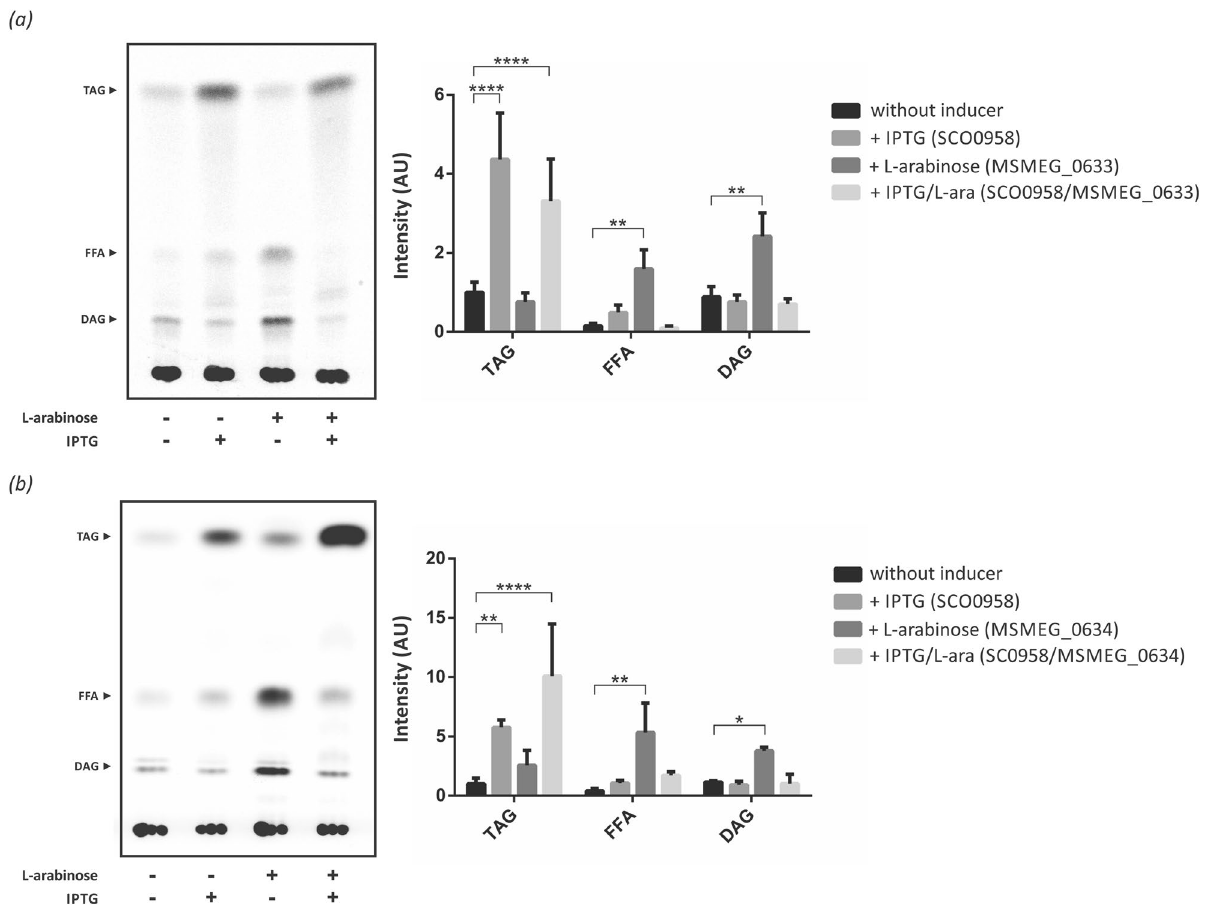
Figure 2. Heterologous expression of MSMEG_0633 and MSMEG_0634 proteins in E. coli . Total lipid extracts from [ 14 C]-acetate labelled cultures of E. coli strains GG-03 ( a ) or GG-02 ( b ) were analyzed on silica gel TLC plates and developed in hexane: diethylether:acetic acid (70:30:1, v/v/v). Quantification of the radiolabelling intensity is shown for both TLC in arbitrary units (AU). The results are the mean values and standard deviation of three independent biological replicates. All results were normalized by OD 600nm and total protein concentration. TAG, triacylglycerol; FFA, free fatty acids; DAG, Diacylglycerol. (+): Inducer added. (−): Without inducer; AU, arbitrary units. Statistical significance was calculated using two-way ANOVA test followed by Bonferroni correction; **** P < 0.0001; *** P < 0.001; ** P < 0.01; * P < promoter 29 . Transformed cells were grown to mid-log phase and then cultivated for 16 h at 23 °C after induction with L-arabinose and/or IPTG. We analyzed the lipid profile of these recombinant strains by metabolic labeling with [ 14 C]-acetate. As shown in Fig. 2a,b, we found that the expression of MSMEG_0633 and MSMEG_0634 increased the intracellular levels of DAG by 3 and fourfold, respectively compared with the same strain grown without the addition of the inducer (Fig. 2). The free fatty acid content of GG-02 and GG-03 strains expressing MSMEG_0634 and MSMEG_0633, respectively, also increased compared with the non-induced strains. The sole expression of SCO0958 in the MPS11 strain was sufficient to promote accumulation of significant levels of TAG. However, co-expression of both SCO0958 and MSMEG_0634 enzymes in strain GG-02 increased TAG production by 12-fold (Fig. 2b), suggesting that the expression of these enzymes are sufficient to synthesize de novo TAG using precursors from the glycerophospholipid metabolism of a non-oleaginous host. Altogether, our results suggest that MSMEG_0633 and MSMEG_0634 are central enzymes for DAG generation in M. smeg- matis and we named them as msPAPα and msPAPβ.